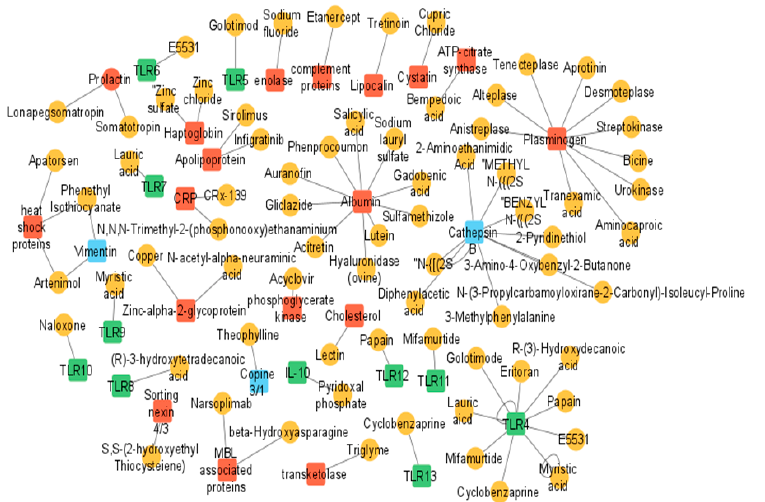
Figure 3. Drug–target interaction network constructed using DrugBank database. Drugs and targets are presented by circles and squares, respectively. Drug–target interactions are represented by the lines connecting related drugs and targets. Green (square) targets represent bacterial infection, blue (square) targets represents viral infection, and red (square) targets represent fungal infection.